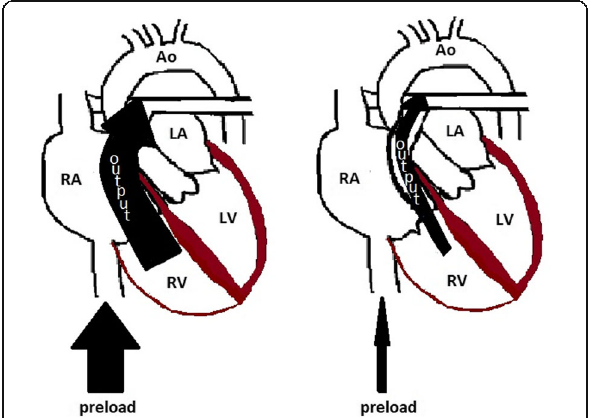
Fig. 8 Depiction of the effects of preload on output from the RV to the pulmonary arteries. If preload is decreased due to venous dilation and pooling of the blood in the dilated venous system, there is decreased filling of the RV and decreased available volume for output